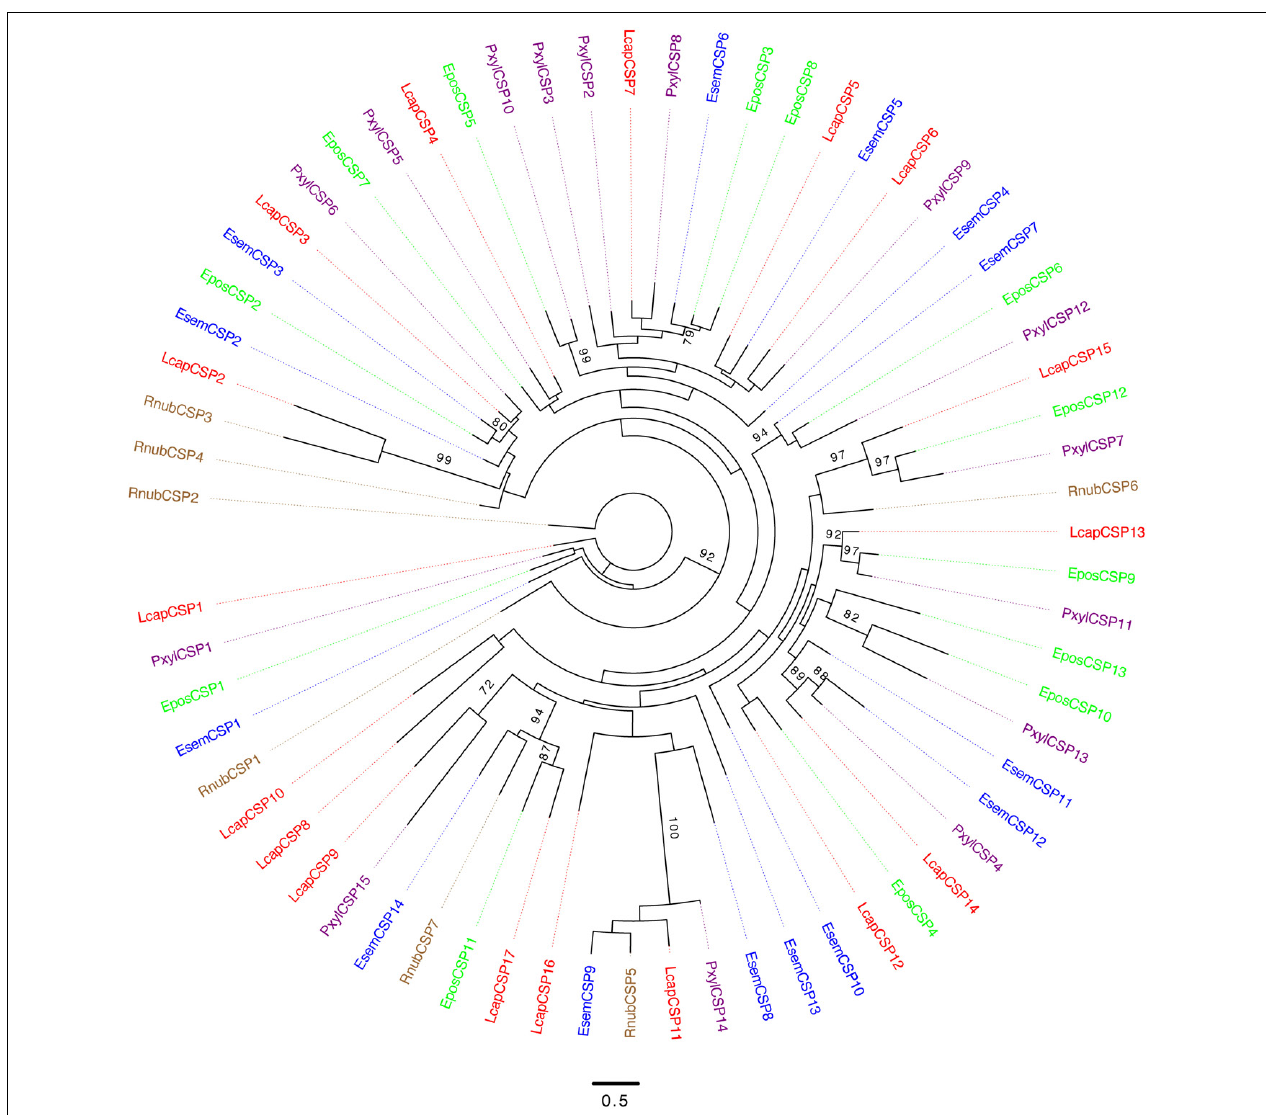
FIGURE 5 | Unrooted maximum-likelihood phylogram based on protein sequences of chemosensory proteins (CSPs). Included are sequences from R. nubila (brown), L. capitella (red), E. semipurpurella (blue), E. postvittana (green), and P. xylostella (purple). Bootstrap support values (500 replicates) are indicated on major branches when > 70%. Sources of included CSP sequences, along with their accession numbers (when applicable), are reported in Supplementary Data Sheet S4